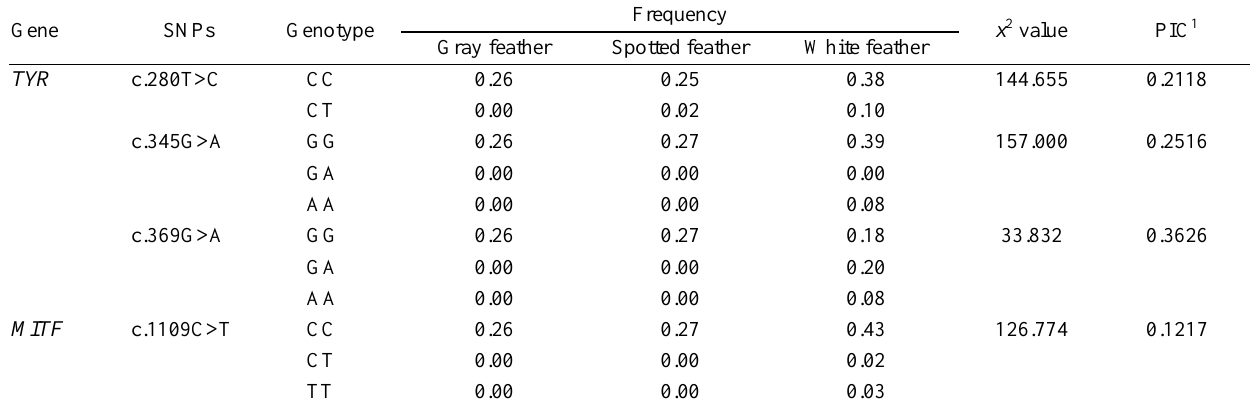
Table 3. The genotype distribution of TYR gene and the MITF gene